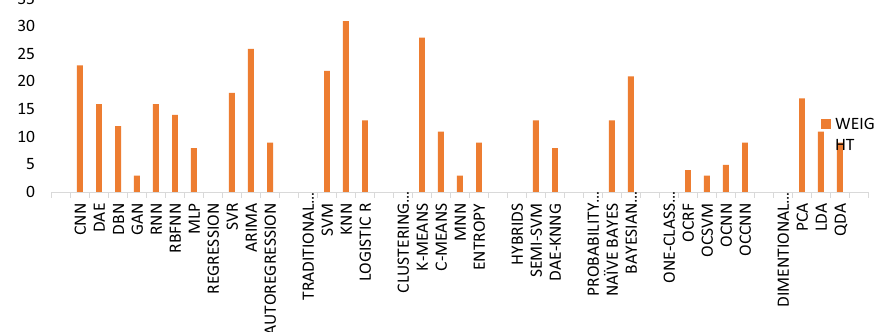
Fig. 5 Categorizations of implemented